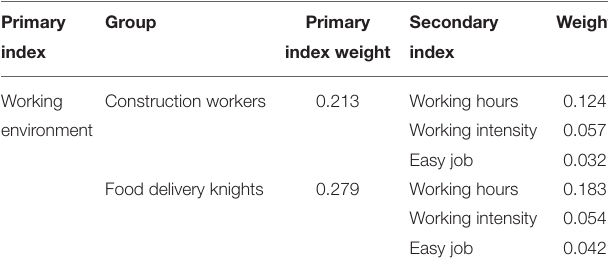
TABLE 7 | Weights of index “working environment”.